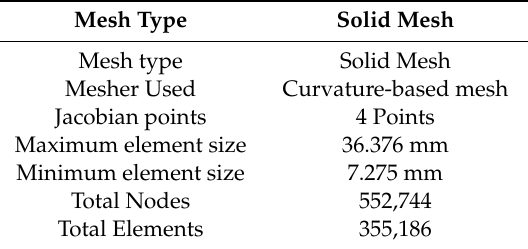
Table 6. Mesh information for FEM (Finite Element Method) analysis.